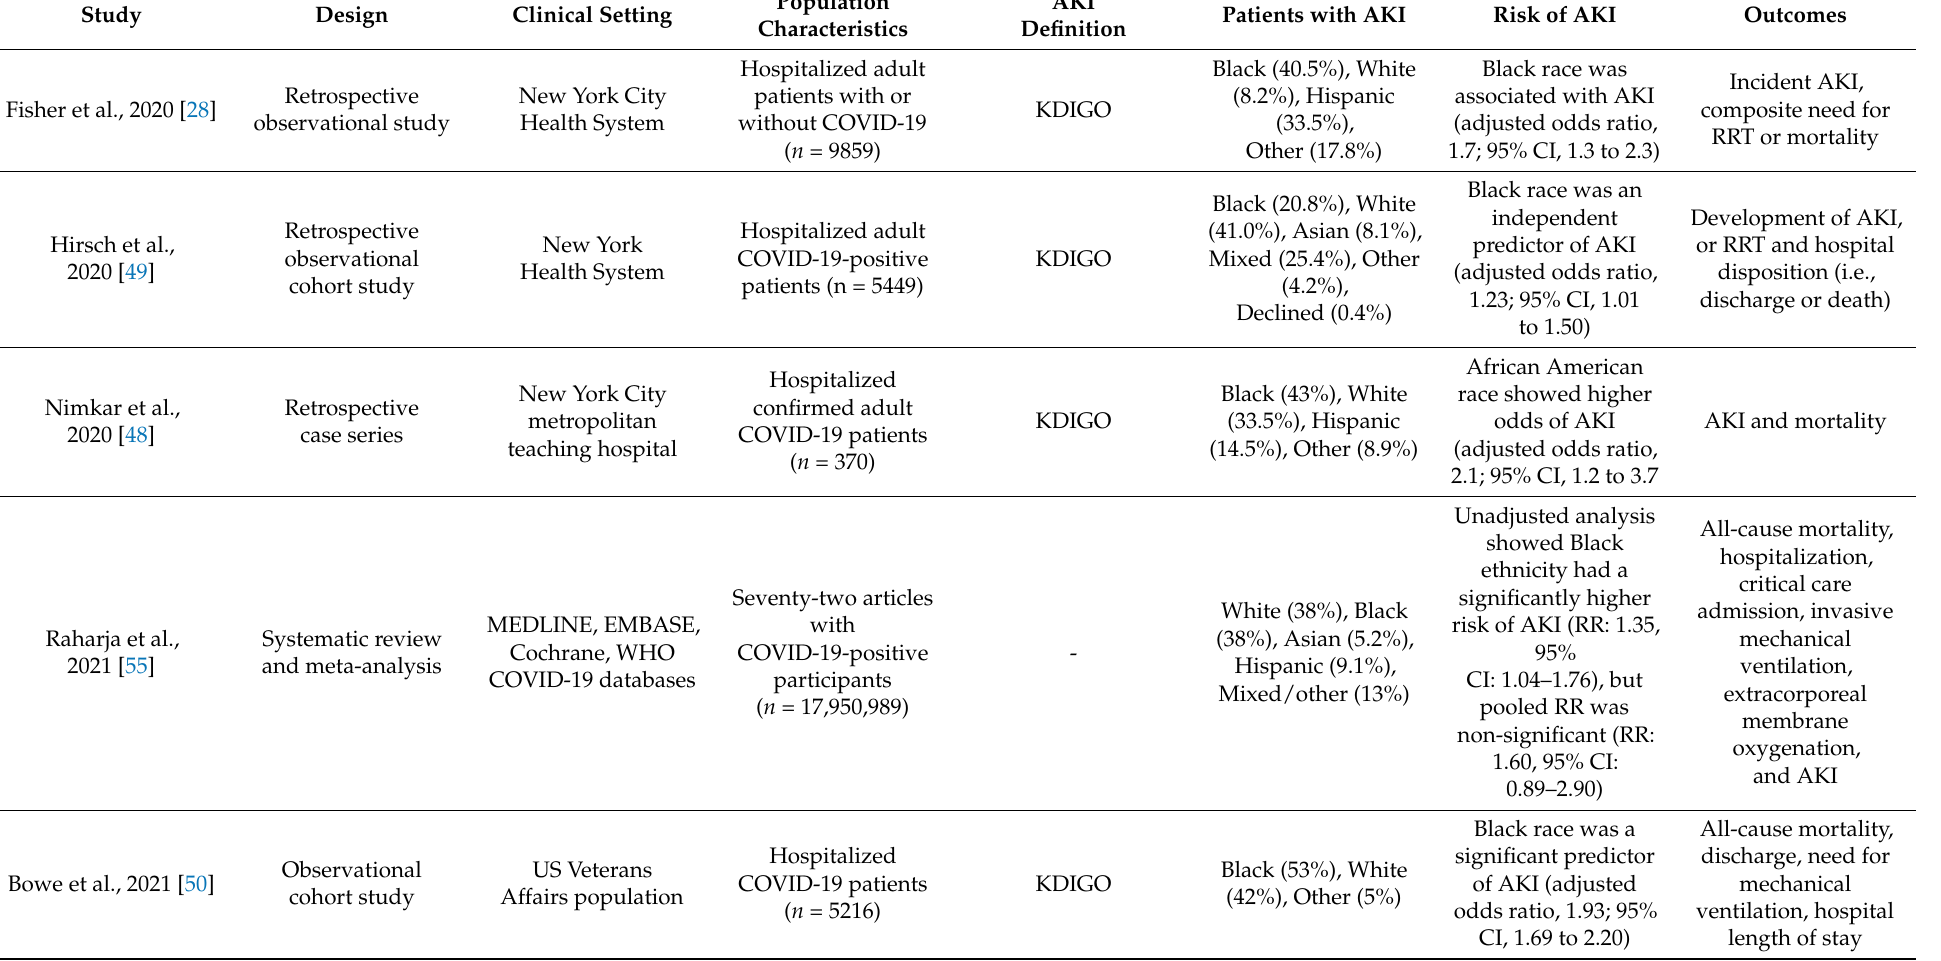
Table 2. Summary of studies showing association between race and COVID-19-induced